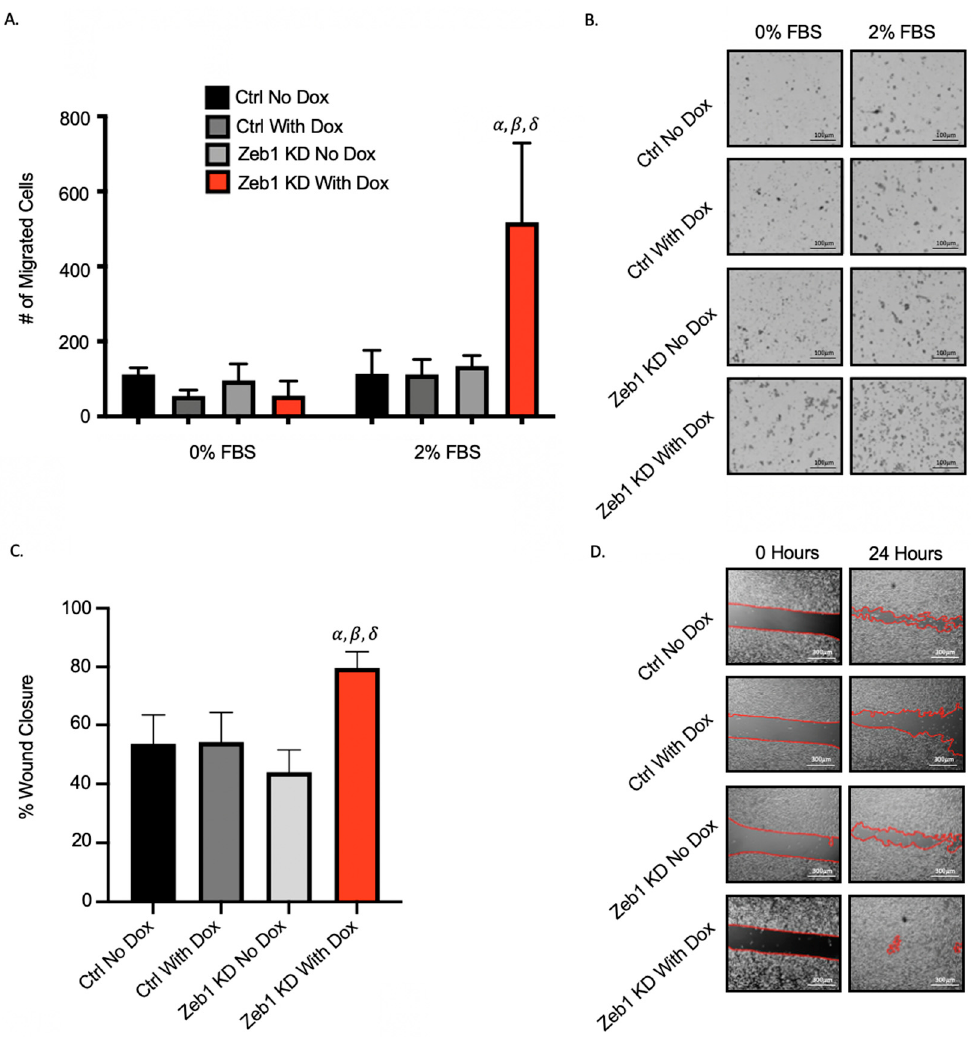
Figure 2. Knockdown of Zeb1 in PC-3 prostate cancer cells increases cell migration. ( A , B ) Transwells were coated with 6 µg/well of gelatin. Cells (5 × 10 4 /well) were added to wells and either control media (0% fetal bovine serum [FBS]) or chemoattractant media (2% FBS) was added and cells were allowed to migrate for 18 h. Cells were fixed with 1% glutaraldehyde and mounted with DAPI-containing mounting media. ( C , D ) For physical barrier wound healing assays, cells were seeded and grown to 90–100% confluency. The physical barrier was removed and cells were allowed to migrate into the wound for 36 h. Representative images are shown for each assay; with migration calculated based on 5 high-powered fields of view (HP-FOV) per well. Black scale bars = 100µm, white scale bars = 300µm. Data is presented as the mean ± standard error of the mean (SEM) ( n = 3). α = significantly different than control (ctrl) no doxycycline (Dox). β = significantly different than ctrl with Dox. δ = significantly different than Zeb1 KD ( Zeb1 knockdown) no Dox ( p ≤ 0.05).